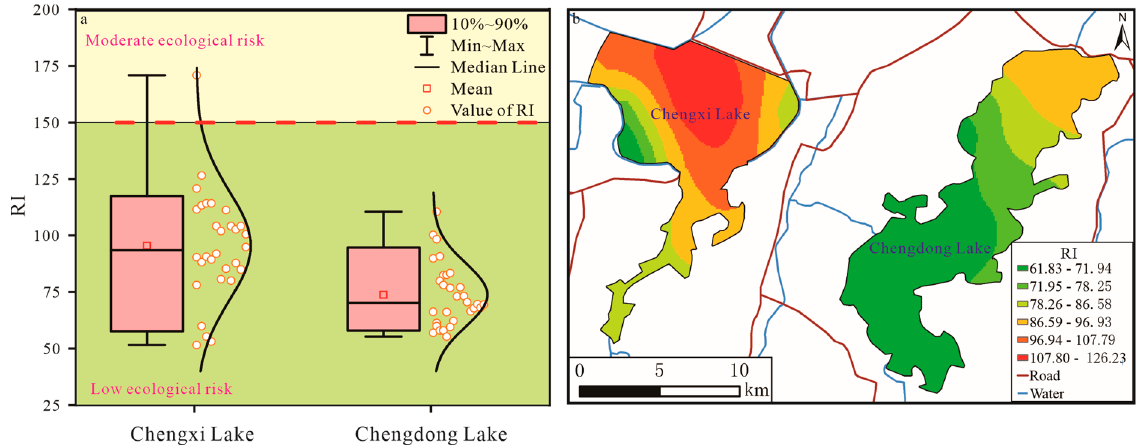
Figure 6. Boxplot ( a ) and spatial distribution ( b ) of RI of sediment heavy-metal elements.